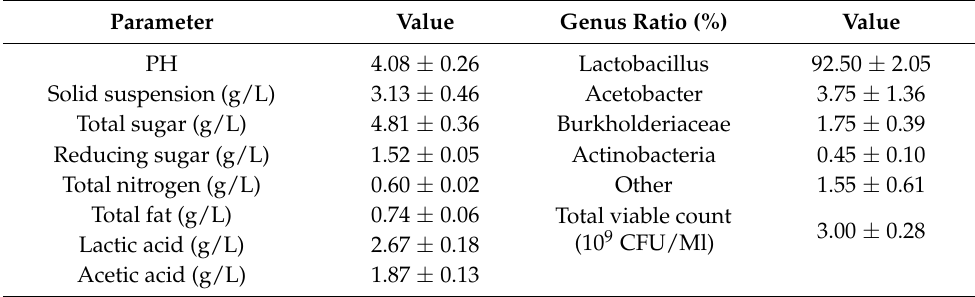
Table 2. Chemical parameters and microbial composition of